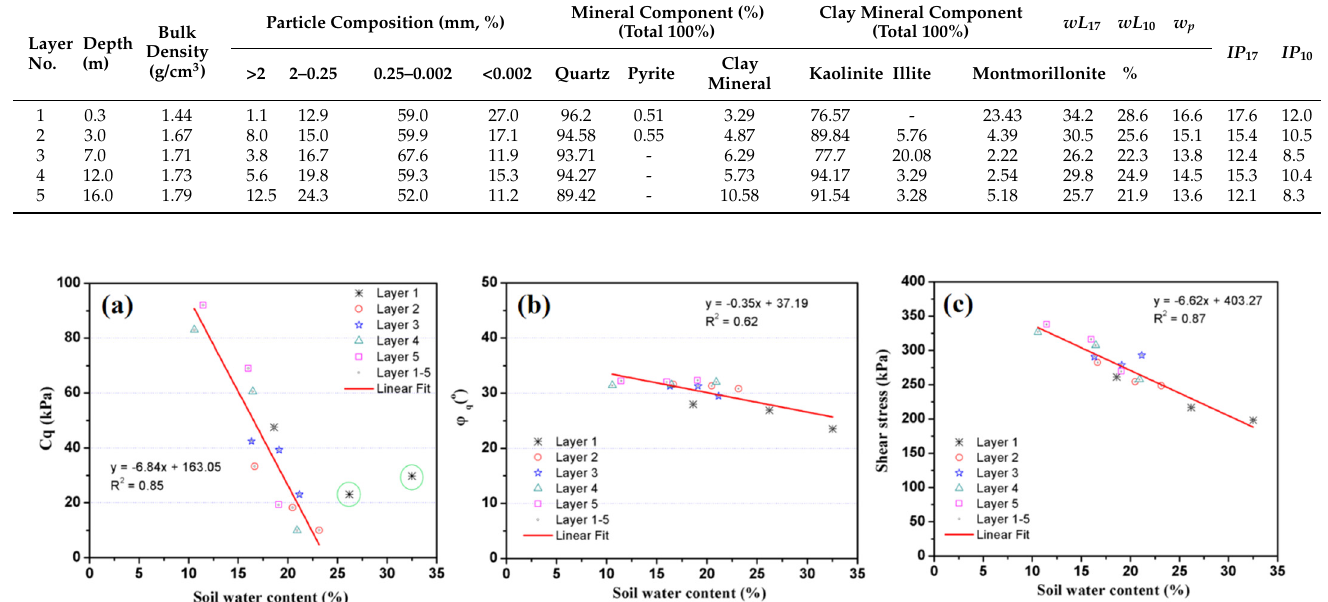
Figure 2. Variations of C q ( a ), ψ q ( b ), and shear stress ( c ) with soil water content at five soil layers. The points in the green circle are not included in the linear fit.